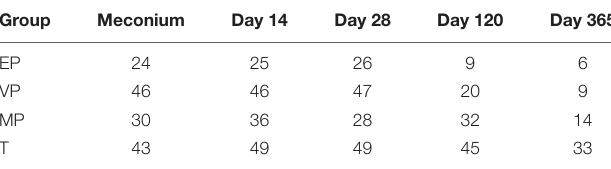
TABLE 3 | Number of fecal samples from each